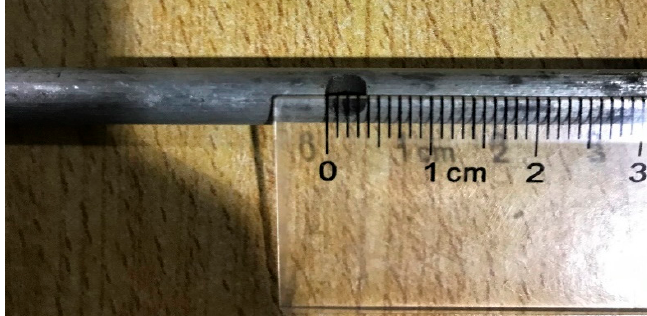
Figure 2. Photo of steel wire specimen with machine-cut notch.